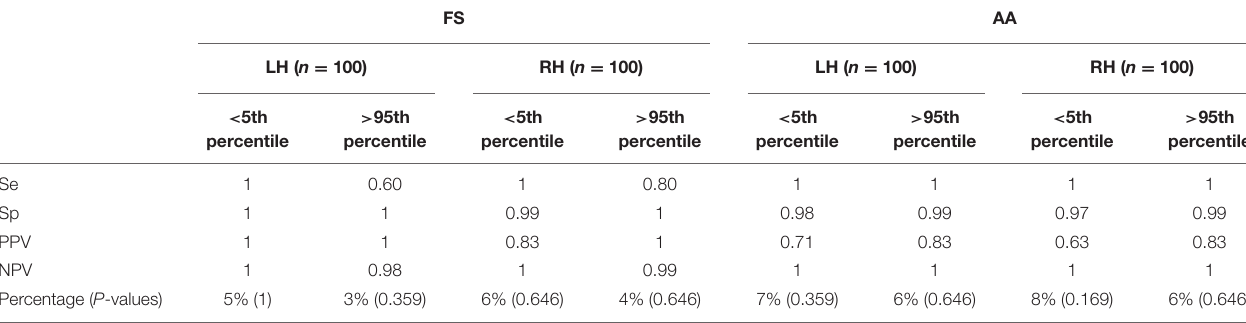
TABLE 6 | Accuracy metrics of FS and AA at identifying ARWiBo abnormal